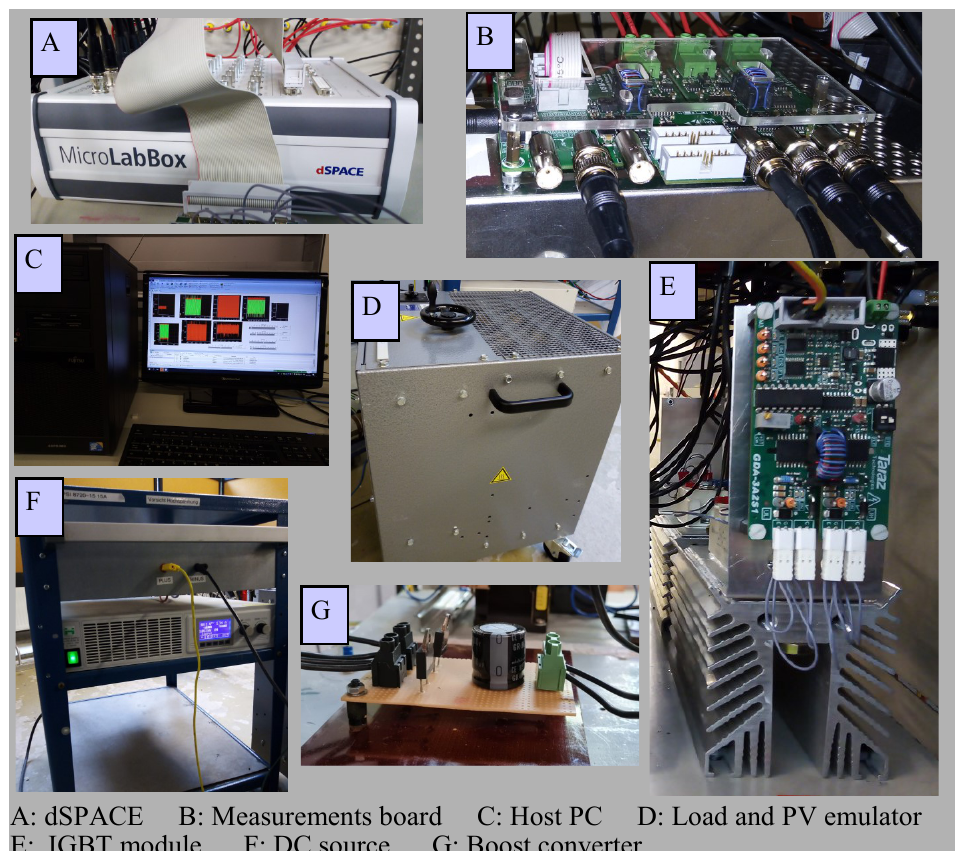
Figure 8. The experimental set-up of the two-stage PV system.